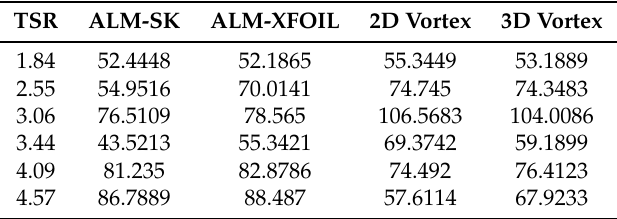
Table 3. Standard deviation of the calculated normal forces for the models at different tip speed ratios (TSRs).